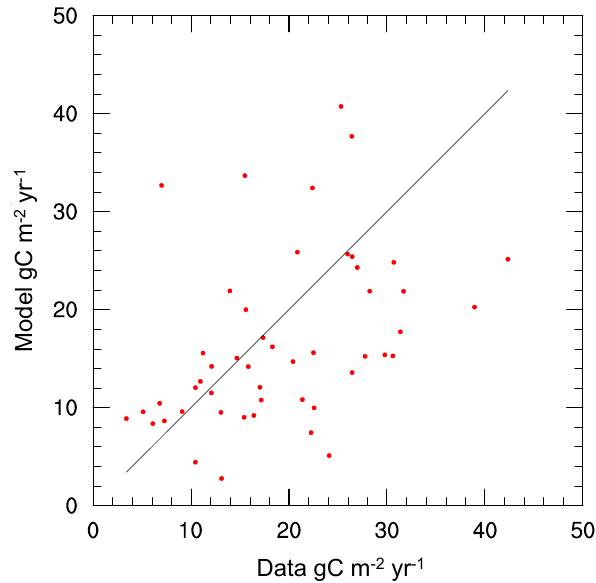
Fig. 6. Modelled peat accumulation rates for pre-industrial times and at different sites compared to a data set of site scale peat accu- mulation rate measurements compiled by Kleinen et al. (2012) with data from Gorham et al. (2003), Kremenetzki (2003), Beilman et al. (2009), and Yu et al.